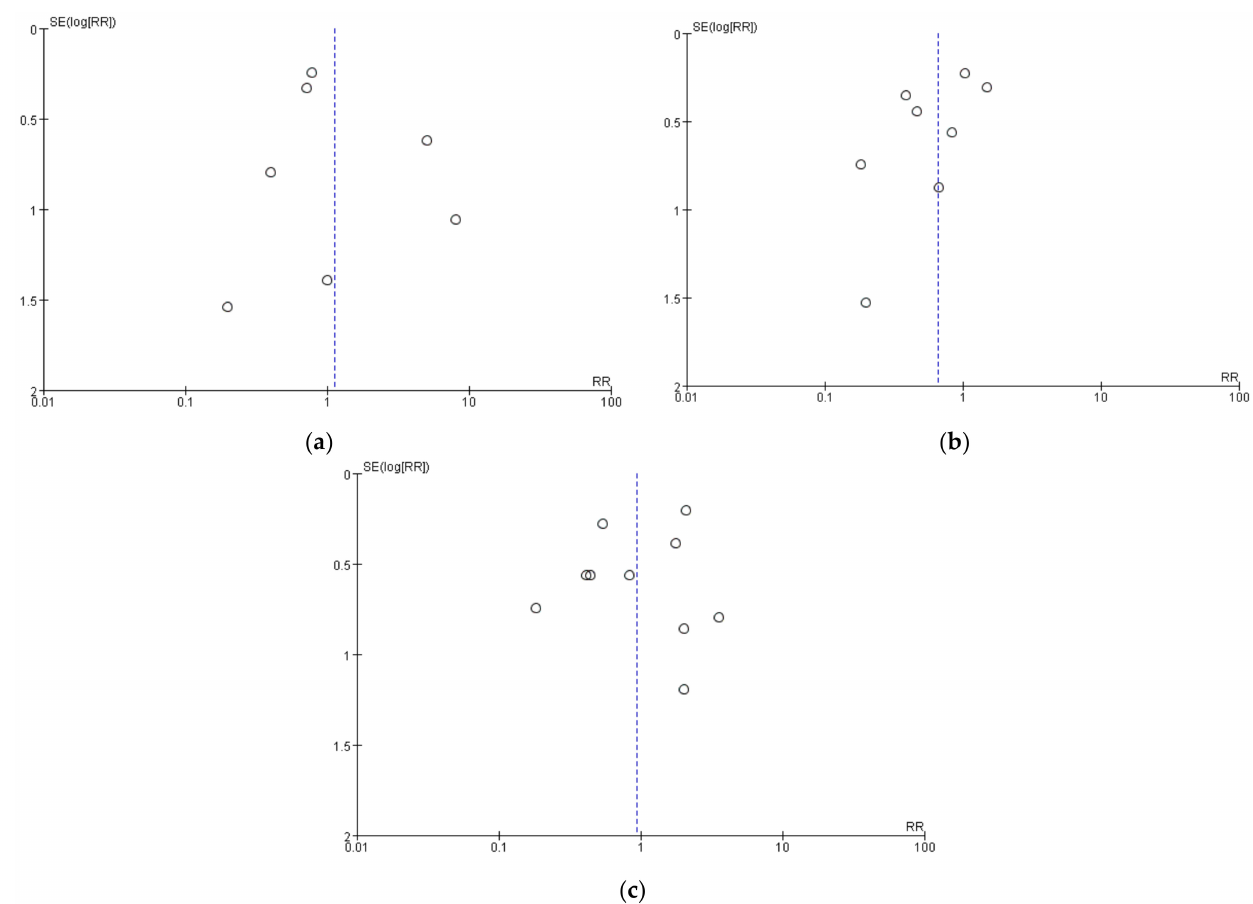
Figure 7. Funnel plot of comparison: ( a ) headaches; ( b ) nausea; ( c )